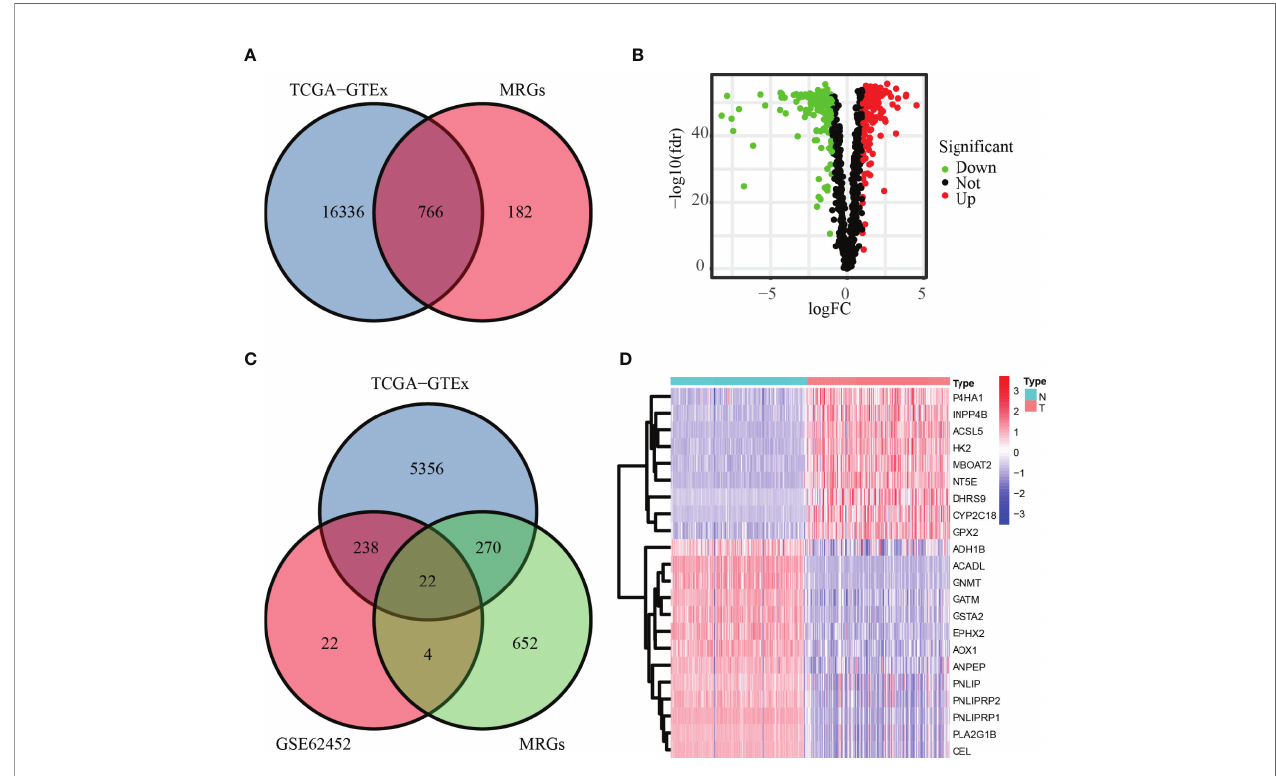
FIGURE 2 | DE-MRGs in PC. (A, B) MRGs in the TCGA database are shown in the Venn diagram and volcano plot. (C) Common MRGs in the GSE62452 dataset and TCGA database are shown in the Venn diagram. (D) Common MRGs are shown in the